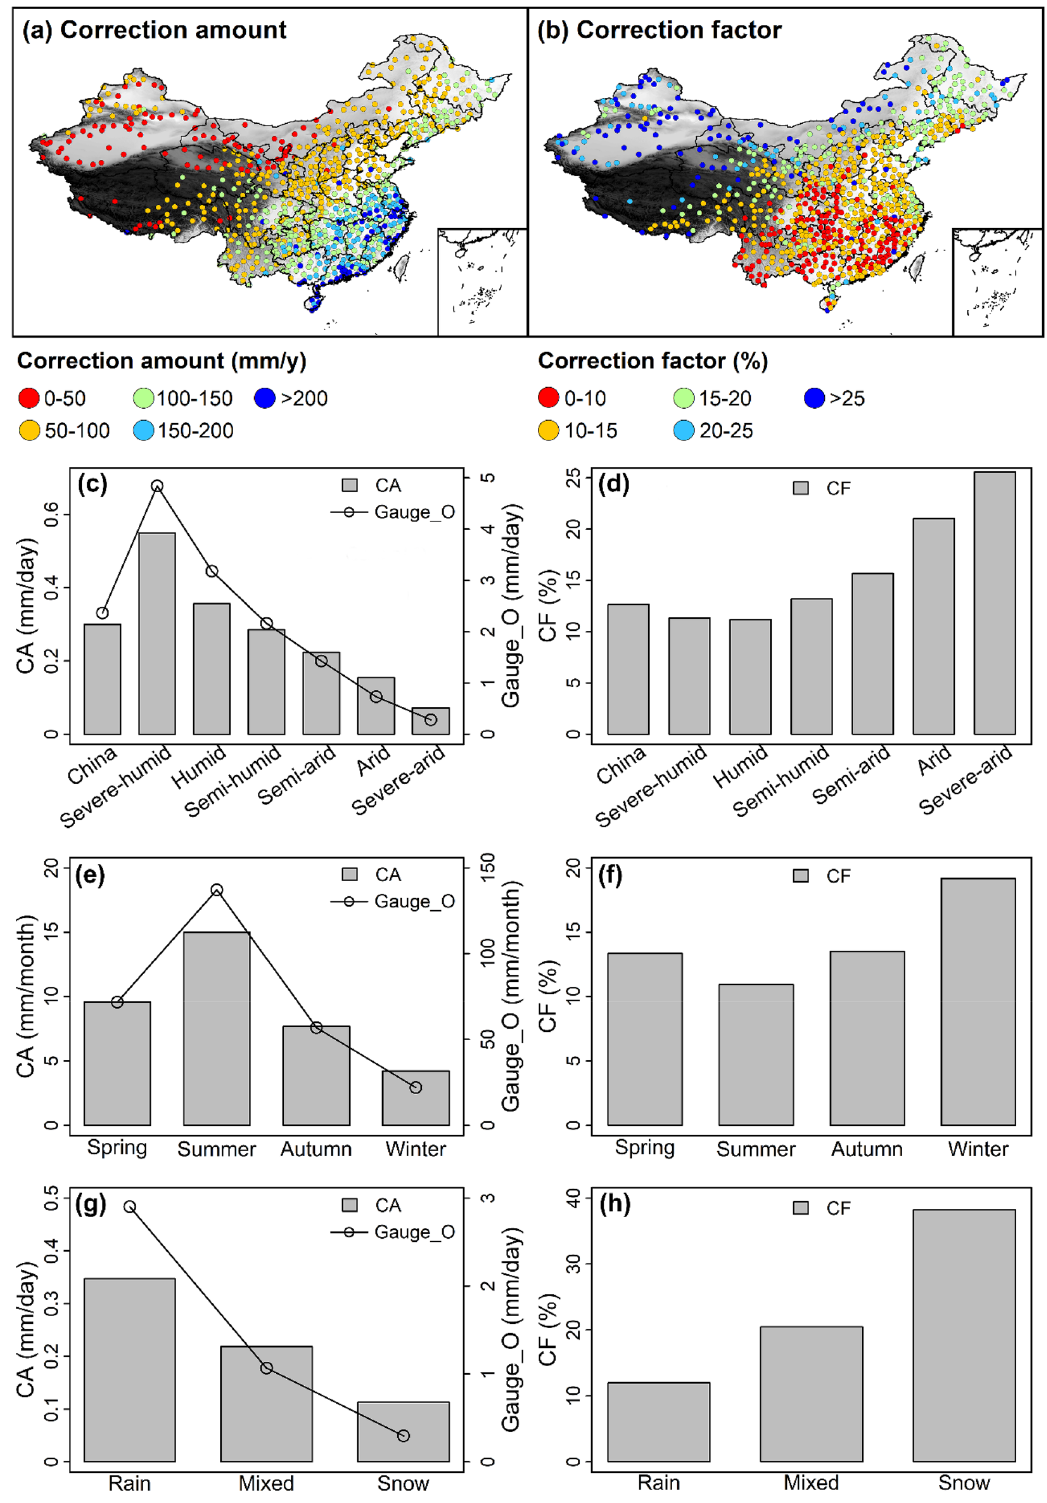
Figure 3. The correction amount (CA) and correction factor (CF) in different locations ( a,b ), climatic zones ( c,d ), seasons ( e,f ), and precipitation phases ( g,h